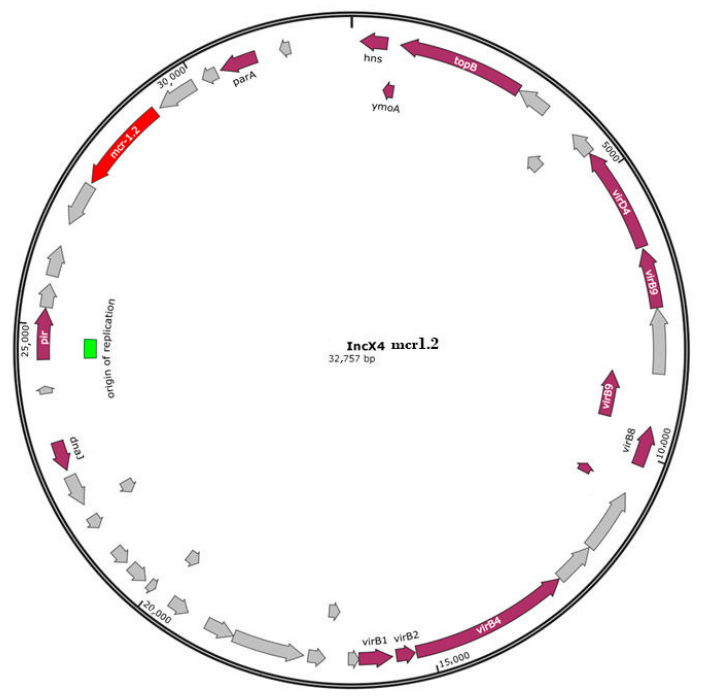
Figure 2. IncX4 plasmid content of the S . Infantis isolate, carrying